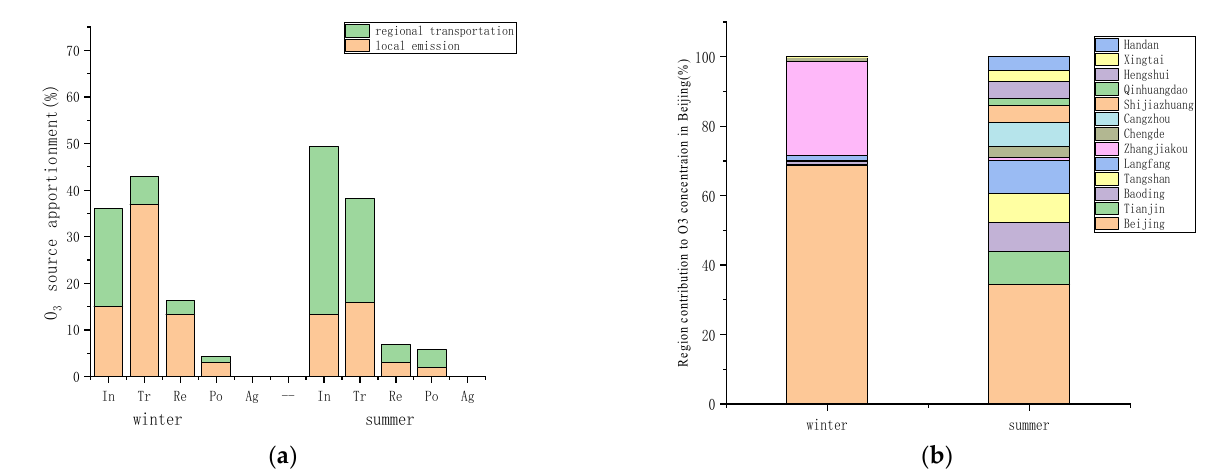
Figure 8. Source apportionment results for O 3 . ( a ) the O 3 source apportionment results, ( b ) the region contribution to O 3 .